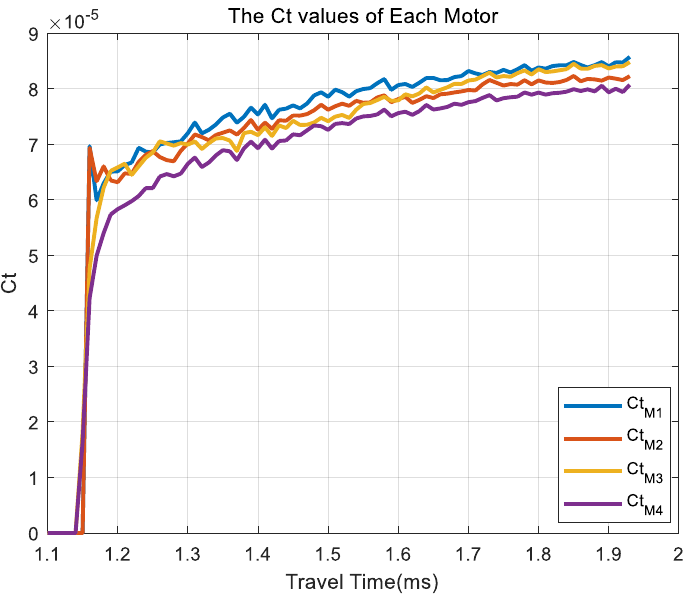
Table 5. Comparing 𝑐 𝑇 of each motor in similar range of RPM.